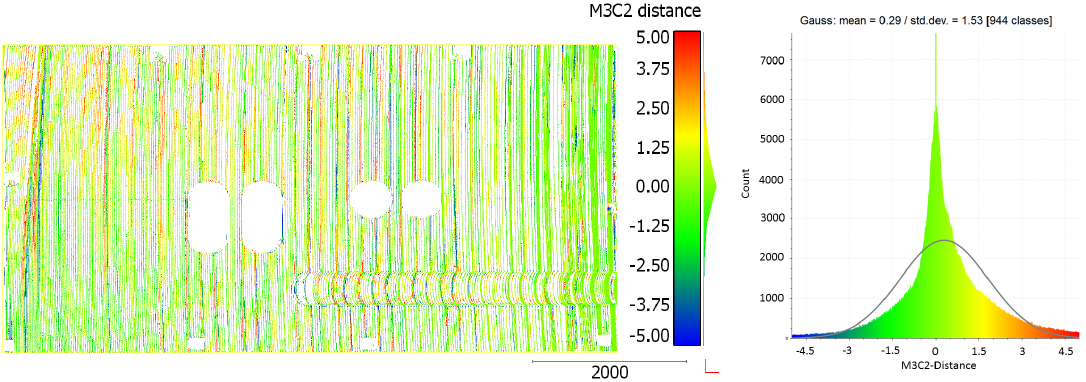
Figure 8. Computed 3D distance (M3C2) between s-TLS and k-TLS with linear